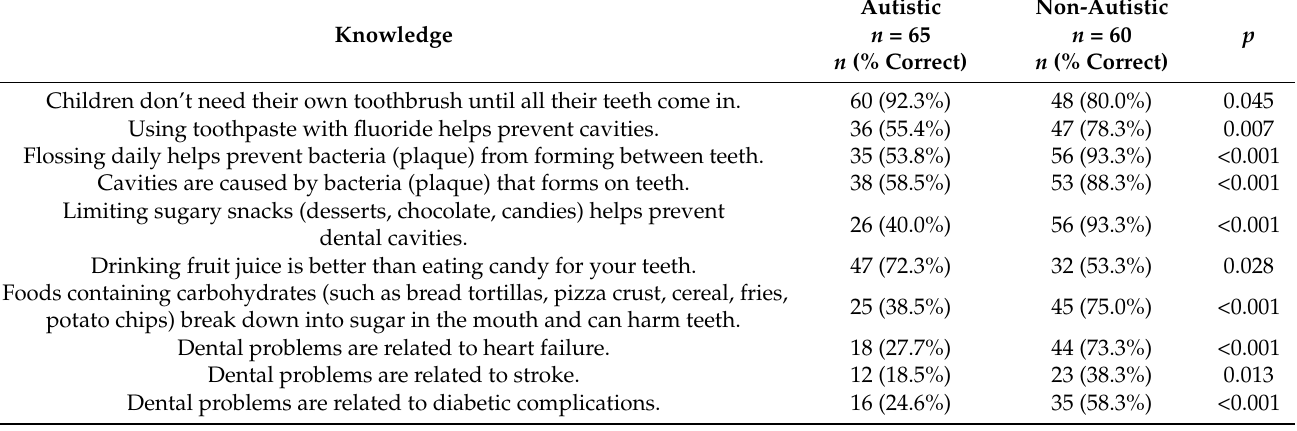
Table 2. Significant Differences in Individual Items of Oral Care Knowledge of Families with Autistic Children And Children Without